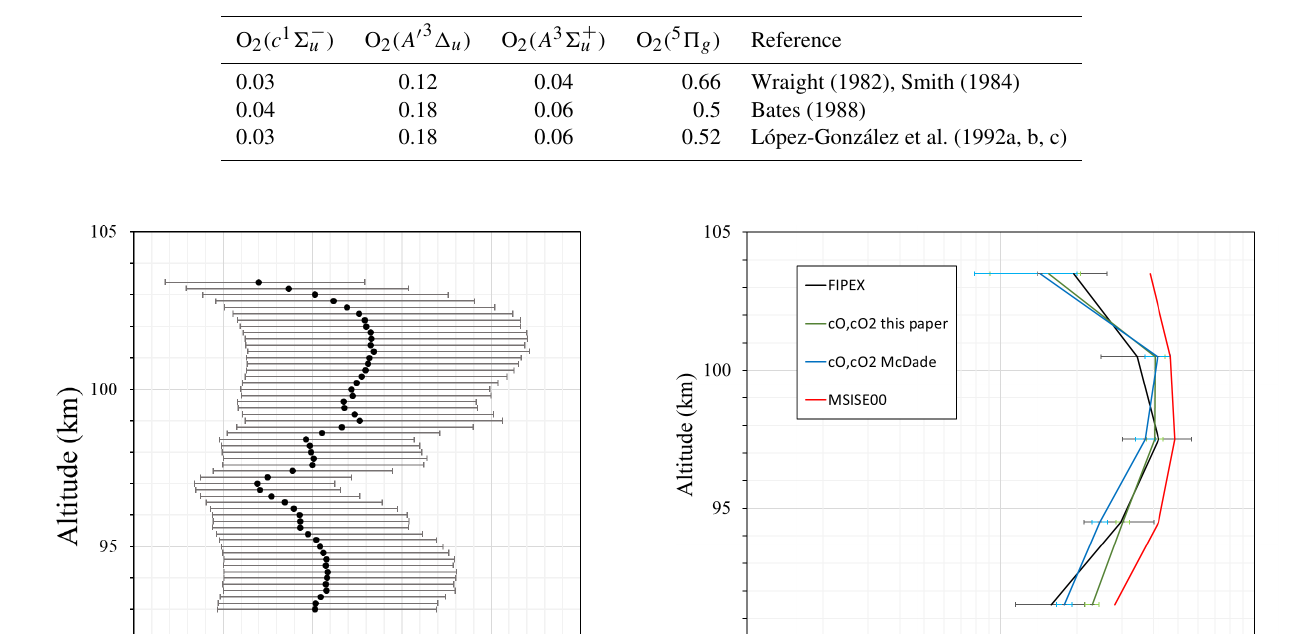
Table 2. Efficiencies α of the different excited states of O 2 .